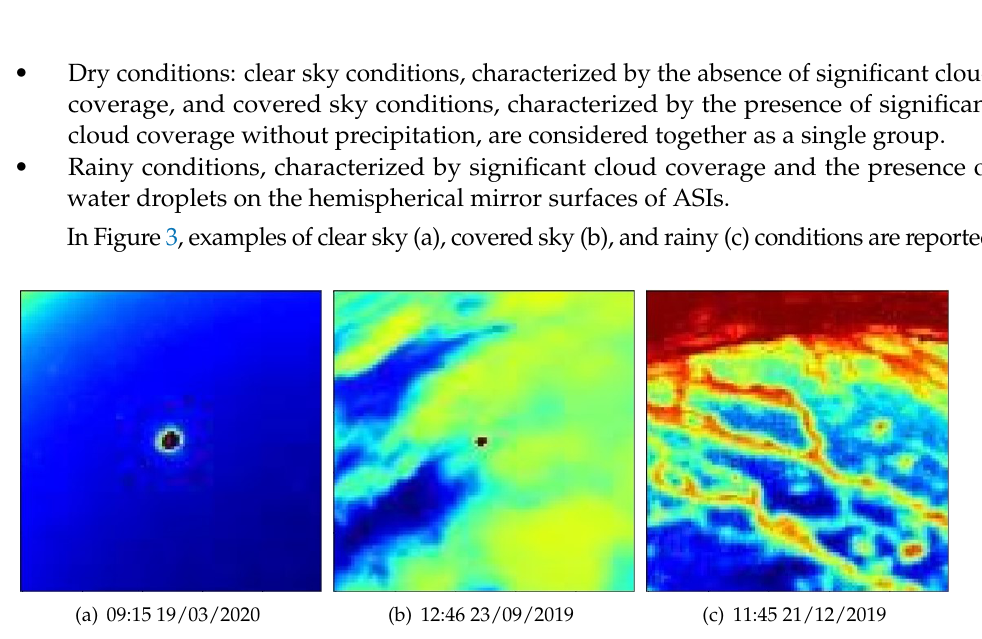
Figure 3. Examples images from each of the three defined groups: ( a ) dry conditions—clear sky; ( b ) dry conditions—covered sky; ( c ) rainy conditions.